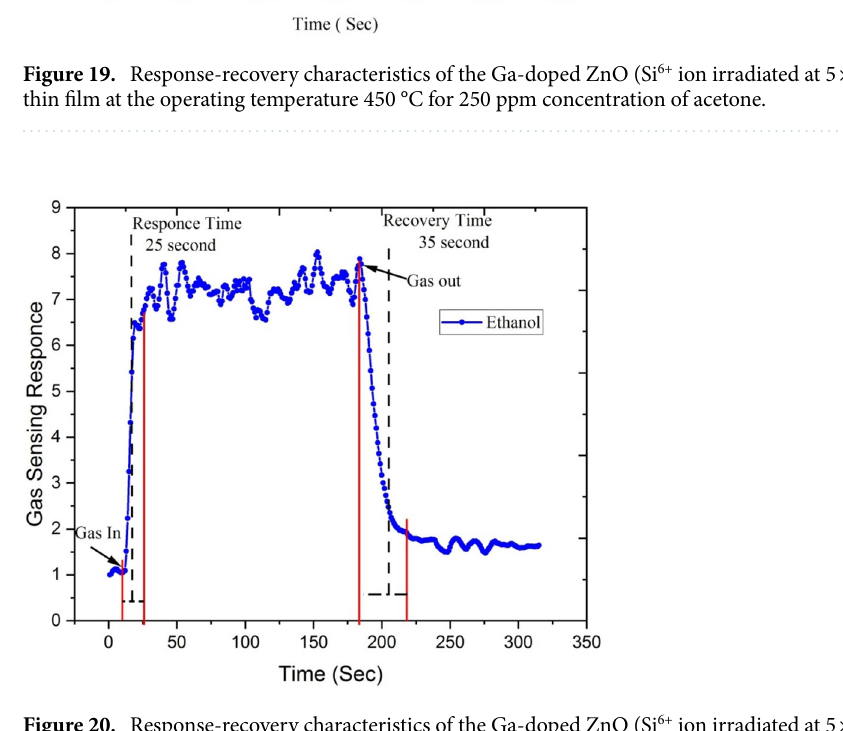
Figure 20. Response-recovery characteristics of the Ga-doped ZnO (Si 6+ ion irradiated at 5 × 10 13 ion fluence) thin film at the operating temperature 450 °C with 250 ppm concentration of